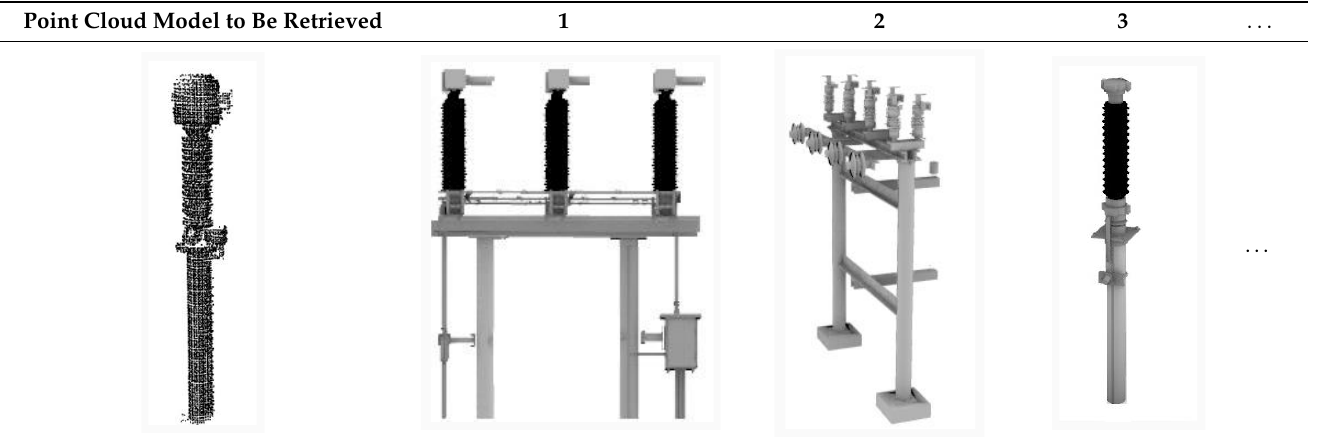
Table 1. Results of the model screening by the bounding sphere. Point Cloud Model to Be Retrieved